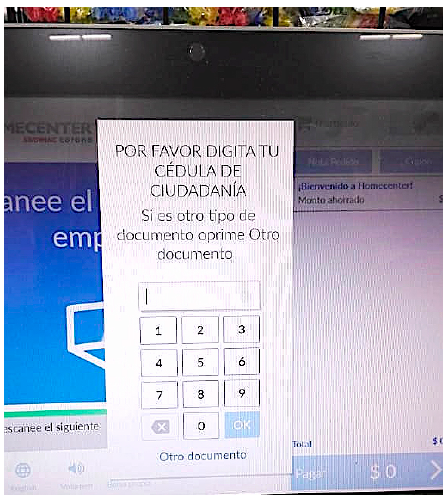
Figure 24. Interface of Home Center self-service checkout in Bogotá. Onscreen instructions requesting data from personal identity card. Foreigners don’t have this card.